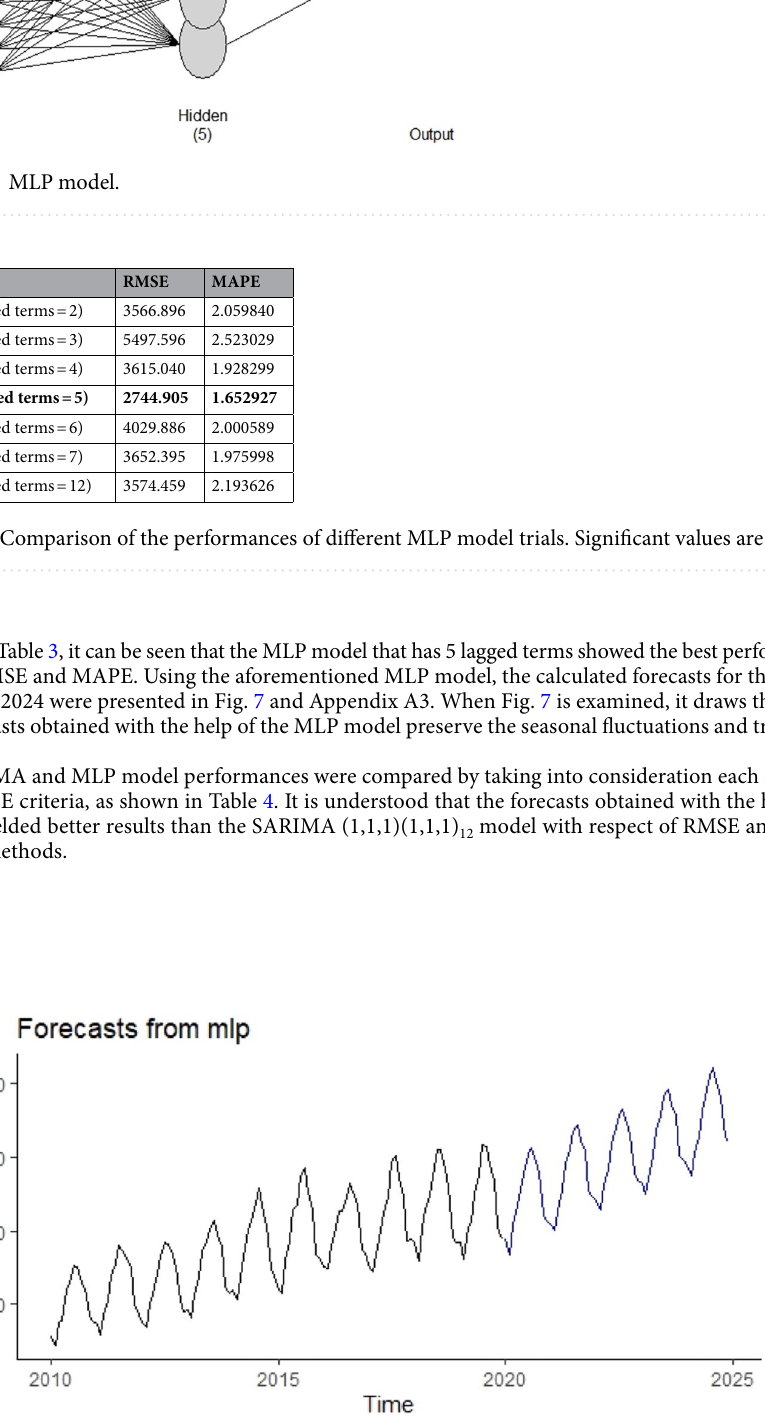
Figure 7. Forecasts obtained using the MLP